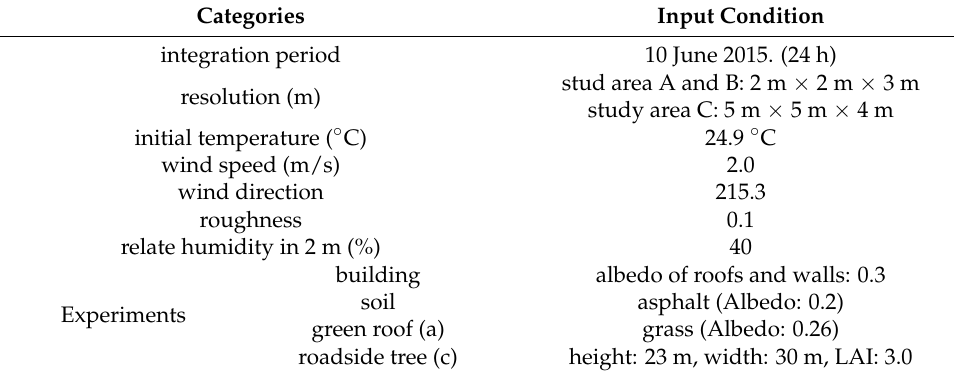
Table 3. Main Configuration File for